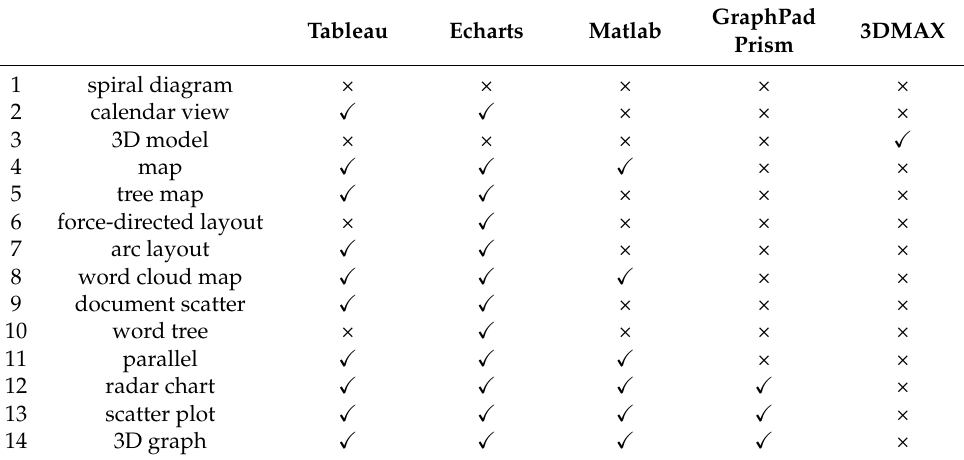
Table 1. Presentable forms of five software or